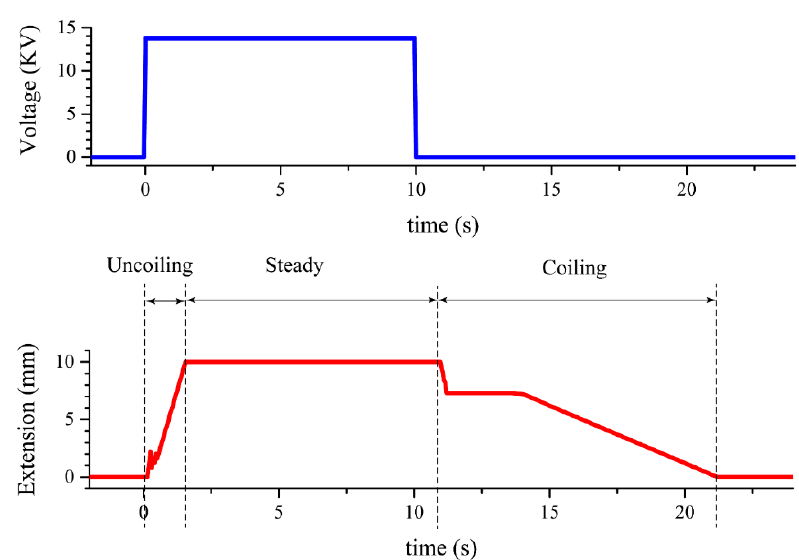
Figure 11. The actuation response and the corresponding applied voltage in time domain. When applying external voltages, the actuator uncoiled linearly with time and extended to its maximum length. When removing the voltage, the actuator coiled to its original shape via the elastic spring.